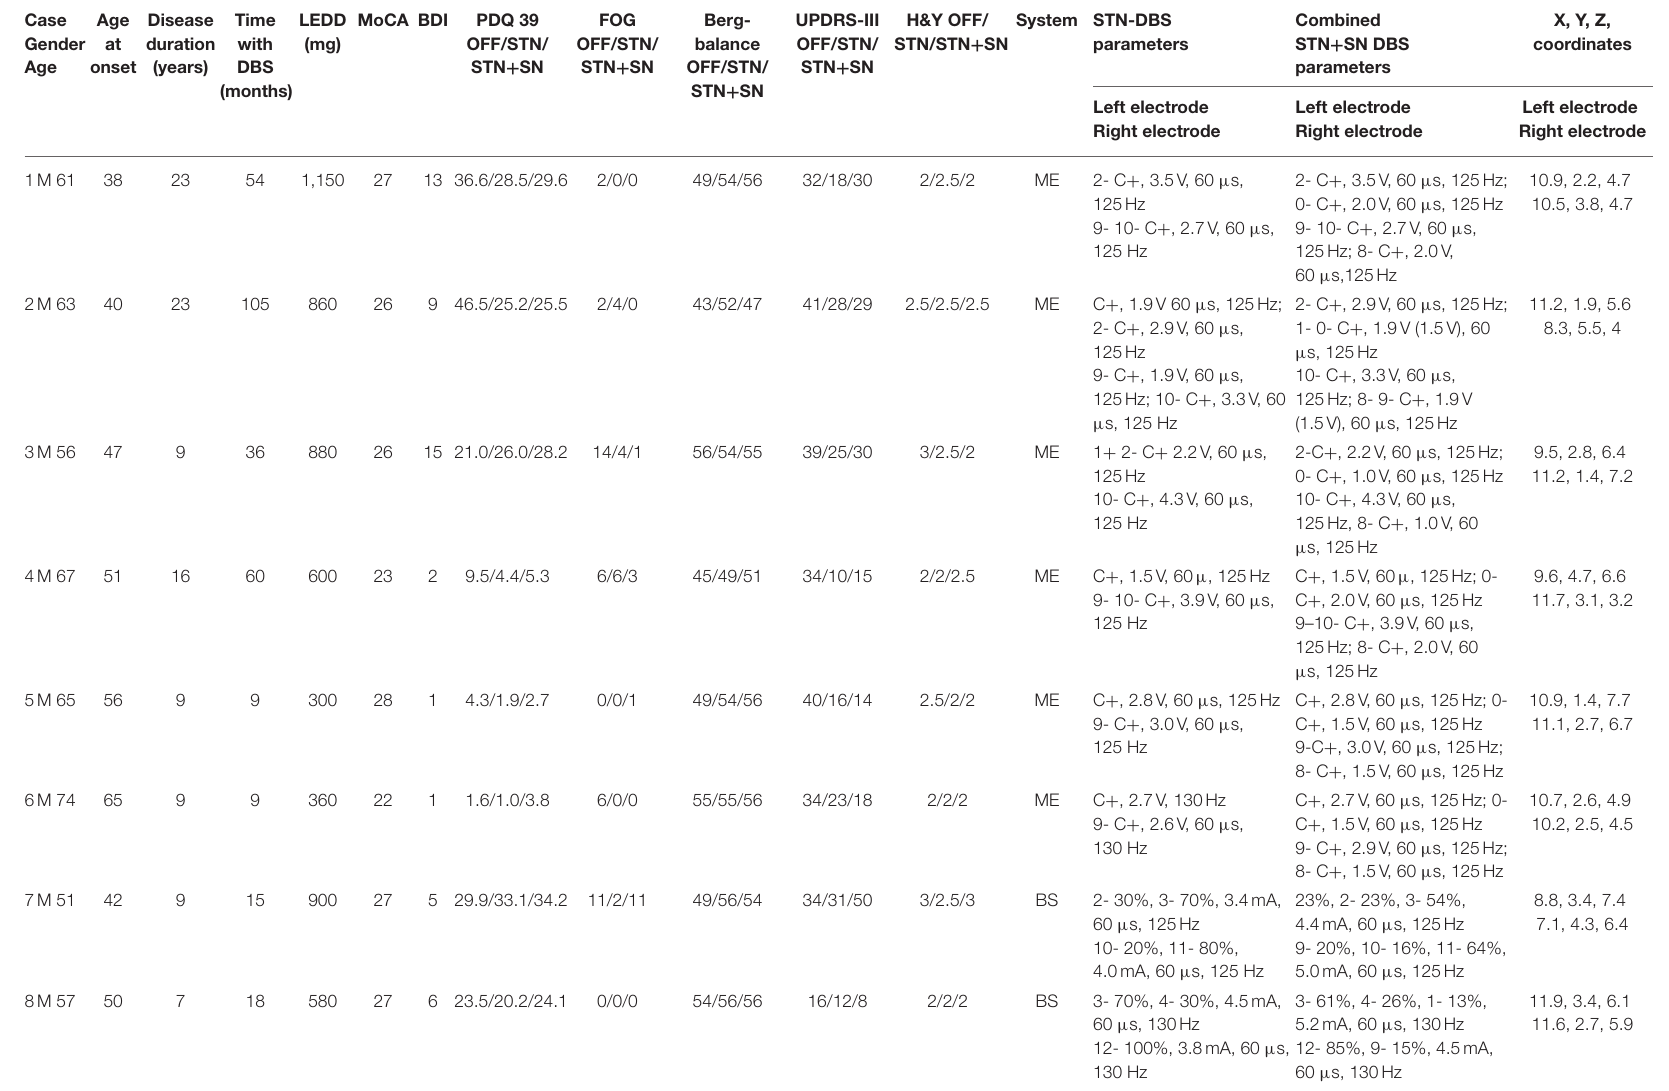
TABLE 1 | Clinical and demographic characteristics of patients with Parkinson’s disease